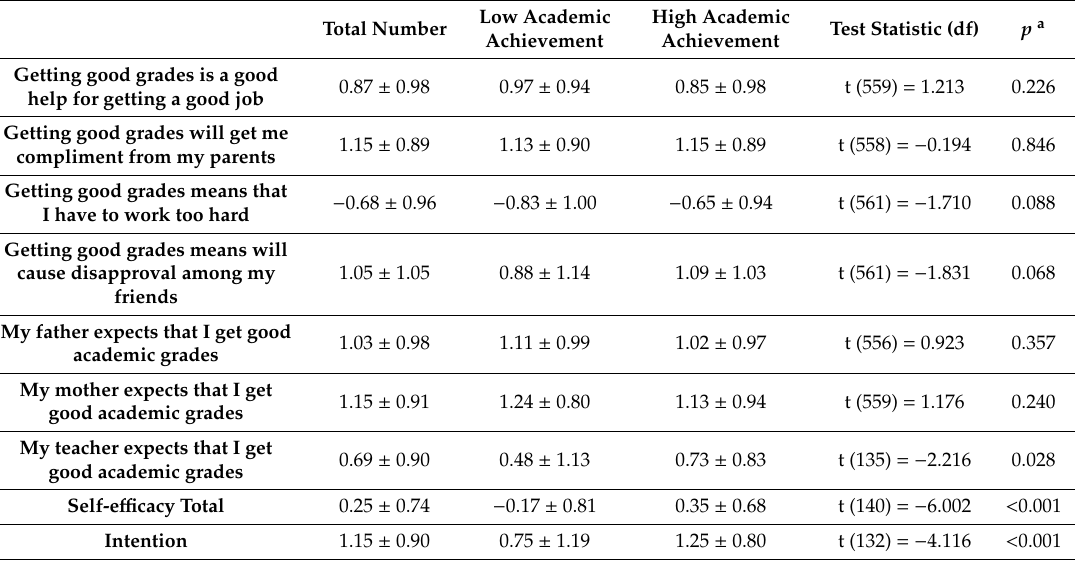
Table 3. Association of Socio-cognitive Factors and Academic Achievement. Low Academic High Academic Total Number Test Statistic Achievement Achievement